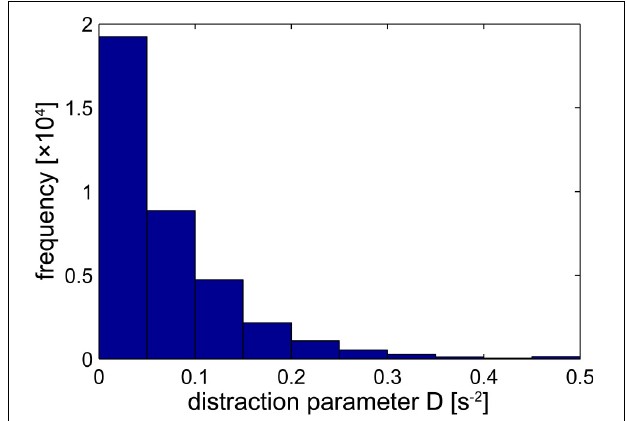
FIGURE 2 | Distribution of the distractor parameter D . For each volume in the functional magnetic resonance imaging (fMRI) time series D is calculated (using a 10-s sliding window) as the inverse of the product of response time and time between distractor presentations. 95% of the values fall below